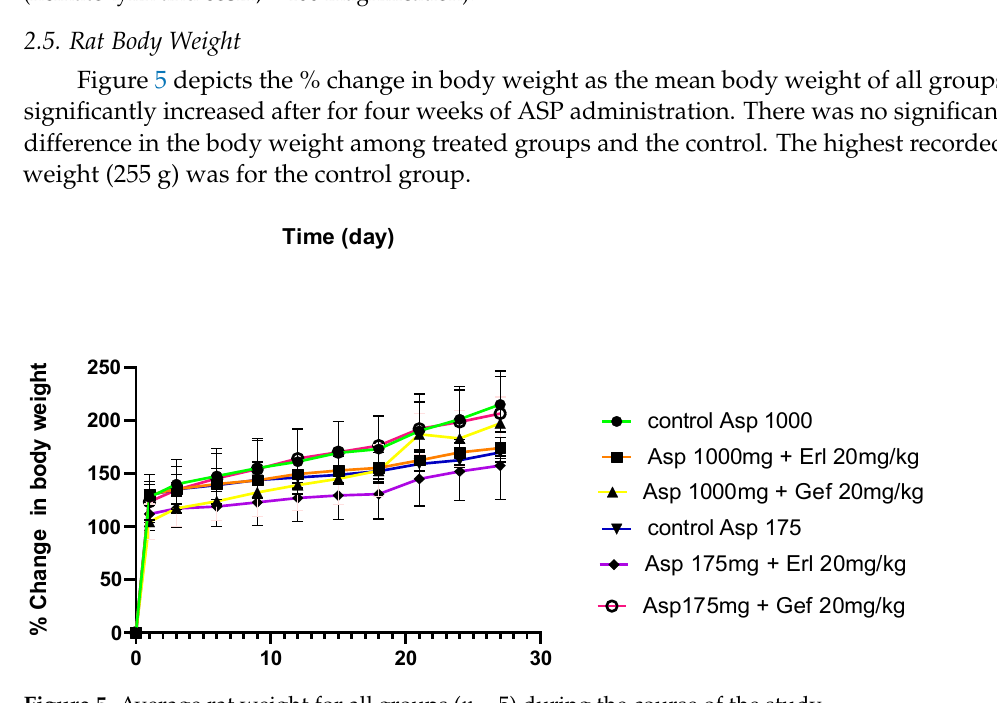
Figure 5. Average rat weight for all groups ( n = 5) during the course of the study.